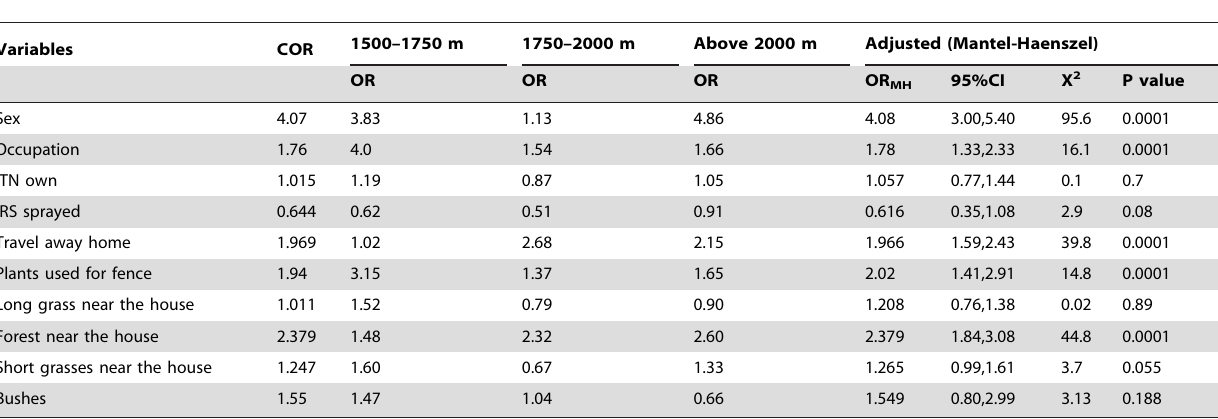
Table 4. Stratification analysis of malaria risk factors stratifying by altitude uses the Mantel Haenszel method in highland villages, northwest Ethiopia,